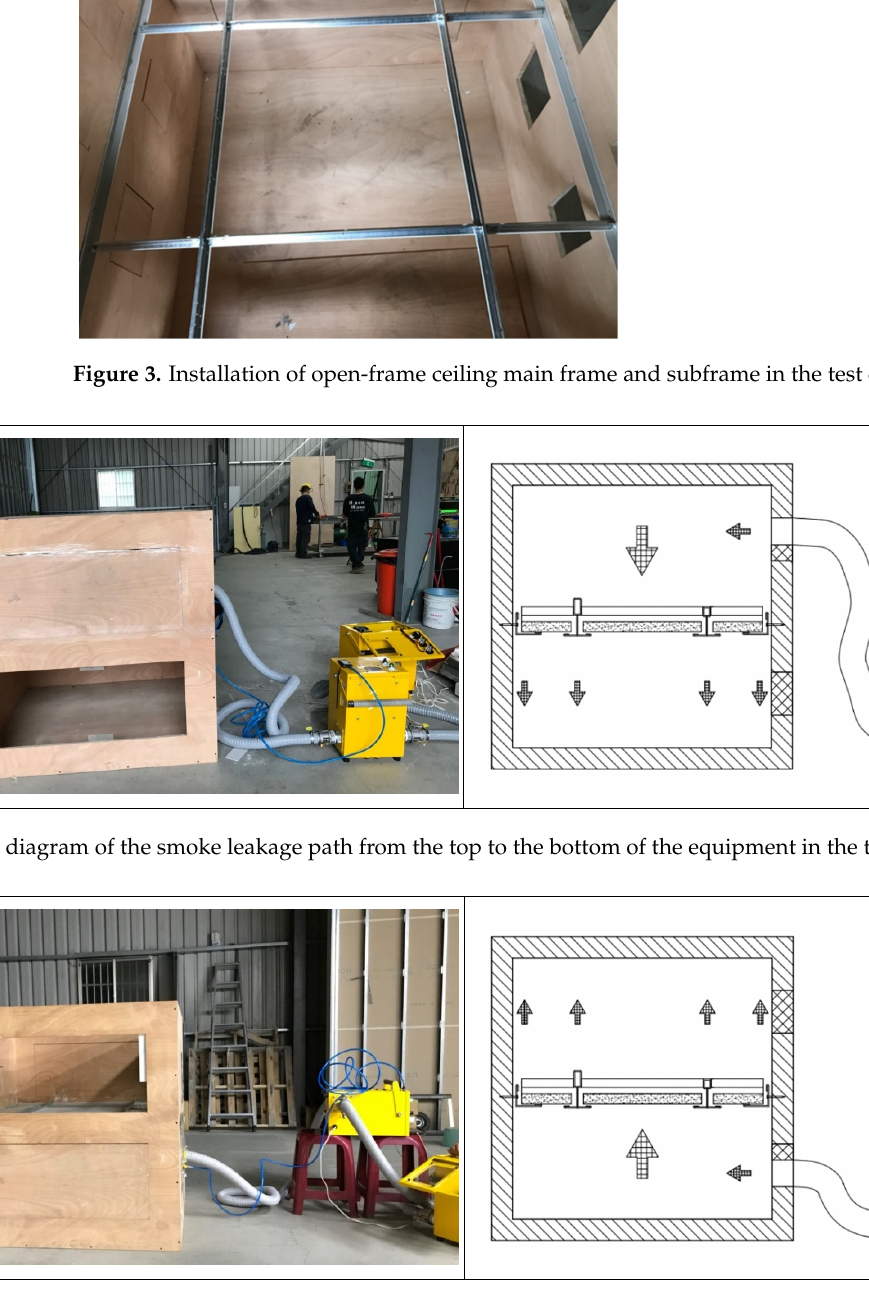
Figure 5. Schematic diagram of the smoke leakage path from the bottom to the top of the equipment in the test chamber.